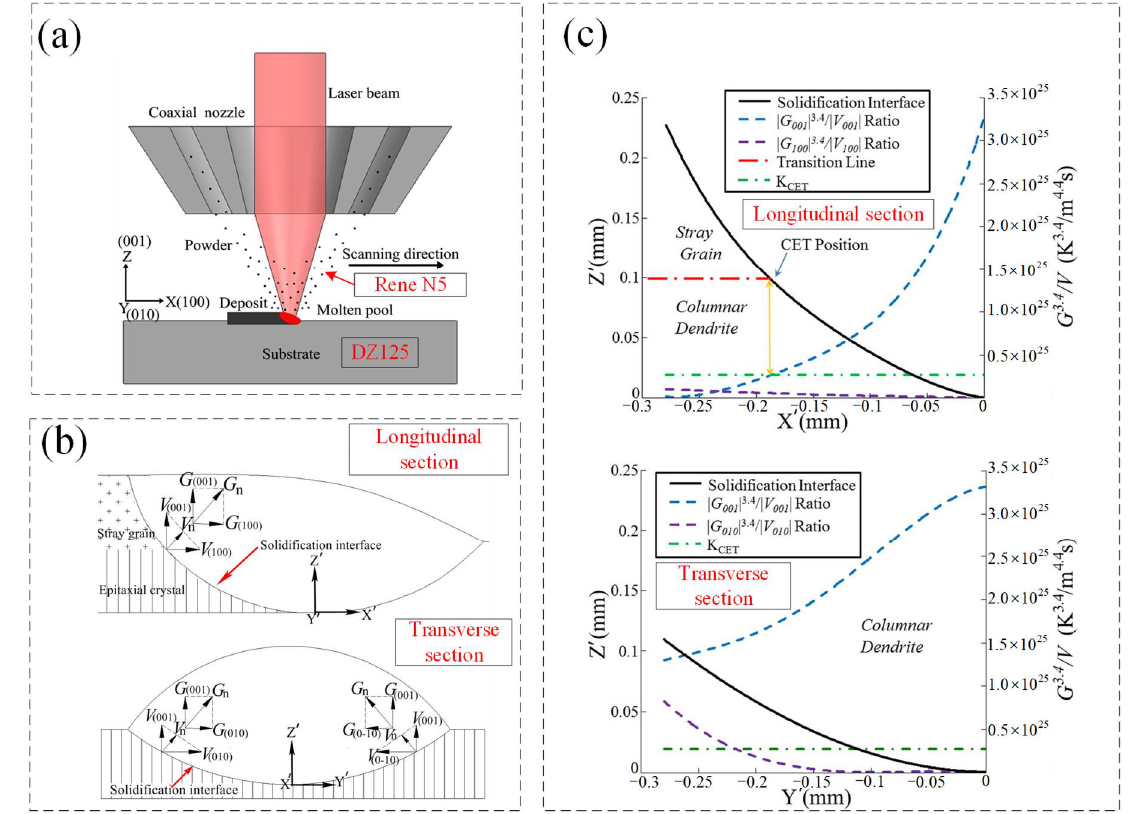
Figure 6. ( a ) Schematic of the LMD process, ( b ) The geometrical relationship of the magnitudes of Ghkl and Vhkl along the preferred growth directions relative to those normal to the solidification interface in the different section, and ( c ) The solidification conditions ahead of the solidification interface in the different section of a simulation deposition. (Reprinted from ref. [84], copyright (2015), with permission from Elsevier).